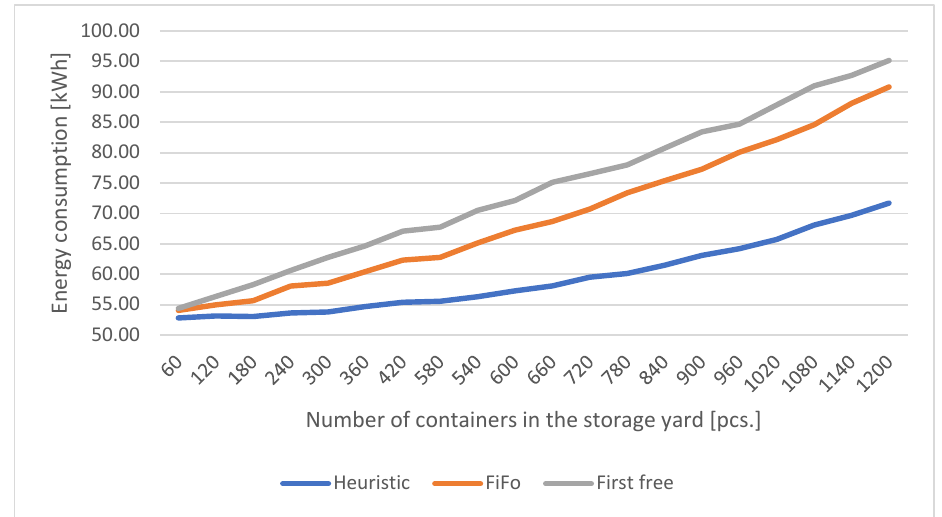
Figure 7. Energy consumption for the unloading of 18 containers. Source: own elaboration. It can be seen that handling the same number of containers when the yard is half full of containers finds a fundamental difference in energy consumption needed to perform the ordered operations. The difference in energy consumption can be seen from opera- tions in a virtually empty yard; however, as the yard becomes more occupied, the ad- vantage becomes even more apparent. The savings in energy consumption are shown in Figure 8.